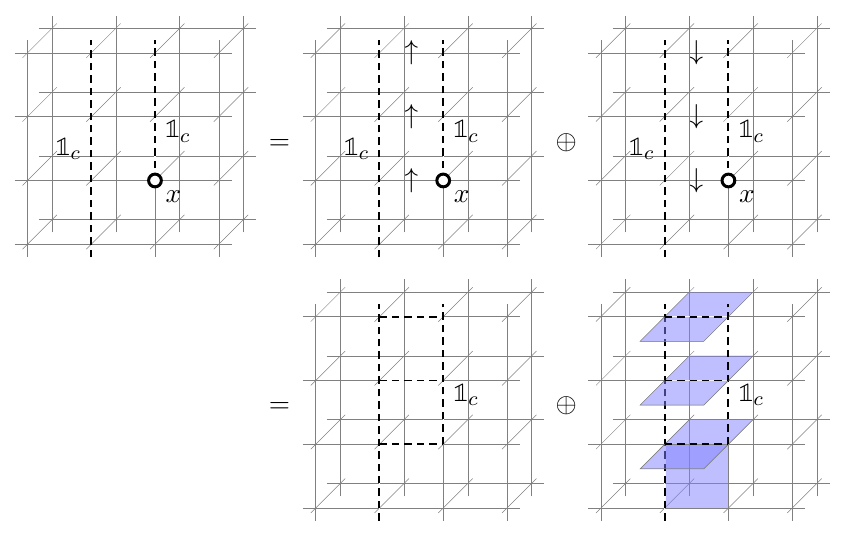
⊗ x is equal to c